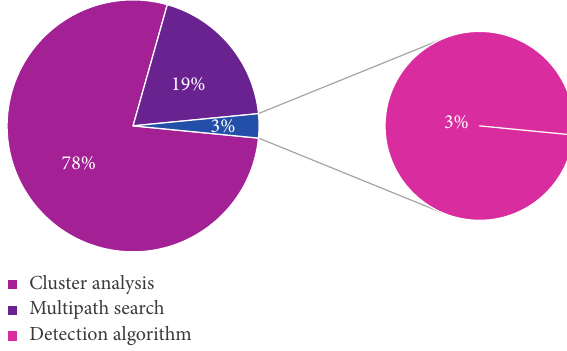
Figure 4: Comparison of algorithm operation time.